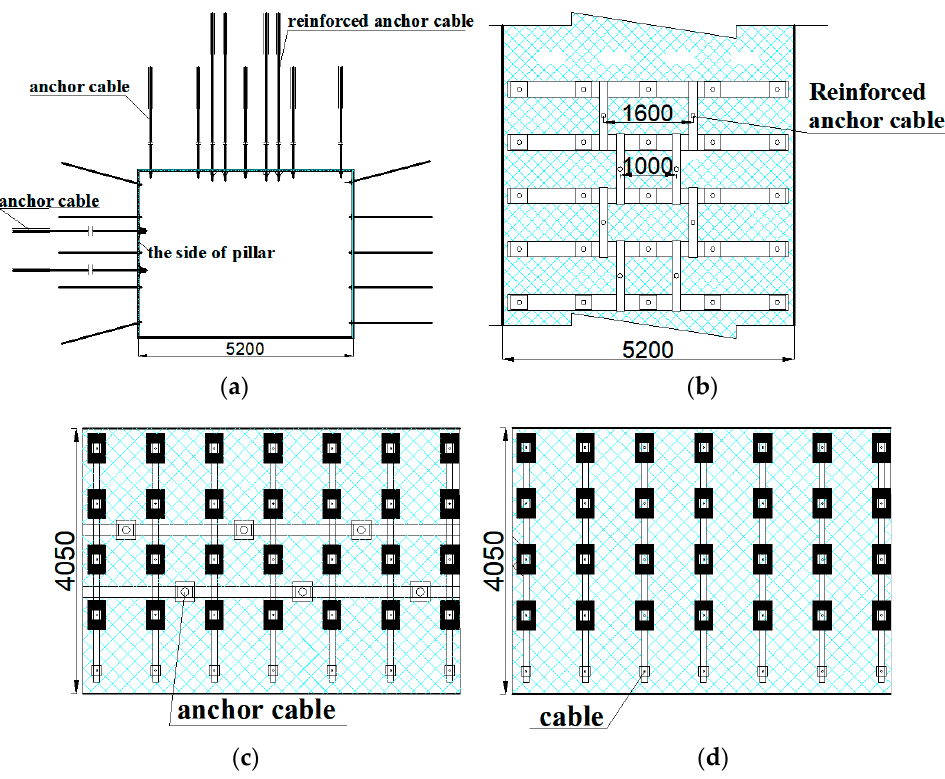
Figure 10. Anchorage support of return air roadway. ( a ) Roadway section support; ( b ) roadway roof support; ( c ) pillar side wall support; ( d ) coal body side wall support.